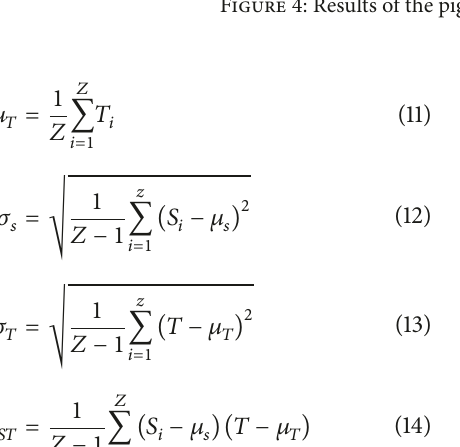
Figure 4: Results of the piglet ellipse fitting contour.